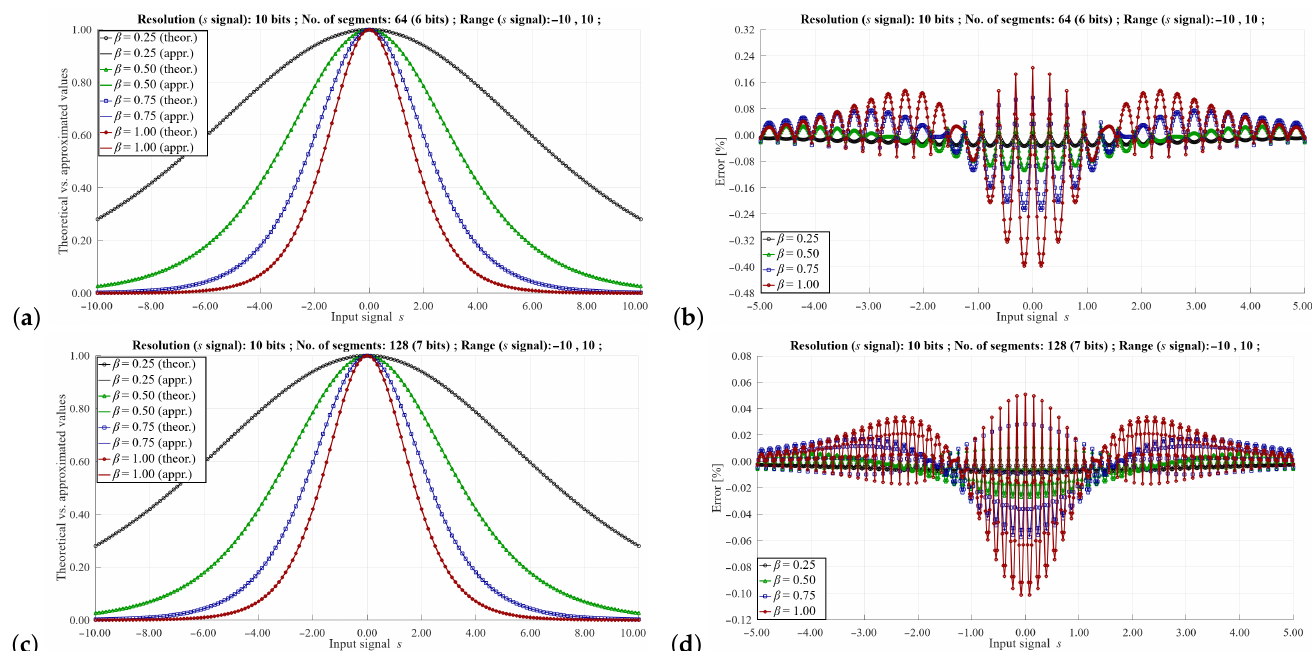
Figure 8. Approximation of the Λ ( s ) function for 10 bits of the signal resolution, the range of ( − 10, 10), for ( a , b ) 64 segments (6-bits) ( c , d ) 128 segments (7 bits). Meaning of diagrams in the left and the right columns as in Figure